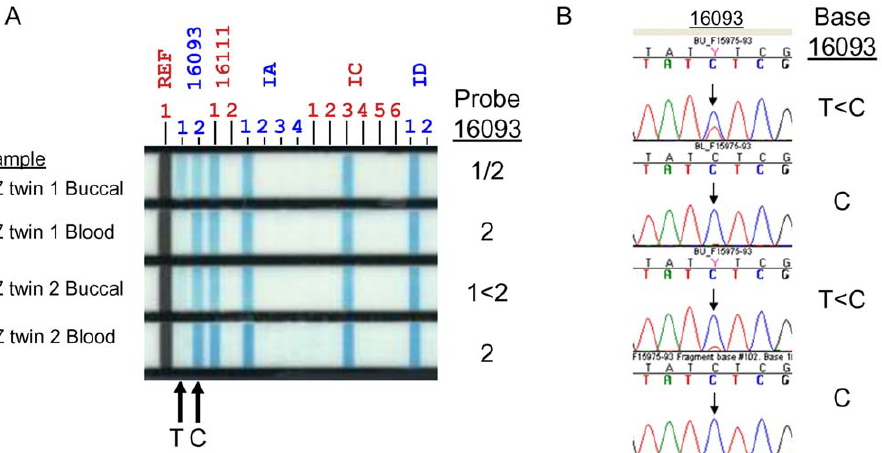
Figure 1. Heteroplasmy at position 16093 detected in buccal but not blood samples in a dizygotic twin pair aged 63 at the time of the study by A) Linear array assay and B) confirmed by dye terminator sequencing. Two probes signals, 16093 1 and 16093 2, were detected by linear array analysis in the buccal samples but not in the blood of this twin pair, corresponding to 16093 T and C. The relative amounts of the 16093 T and C differed between the twins in the buccal and are reflected both by the intensity of the probe signals (A) as well as the peak height ratio in the sequence chromatogram (B).